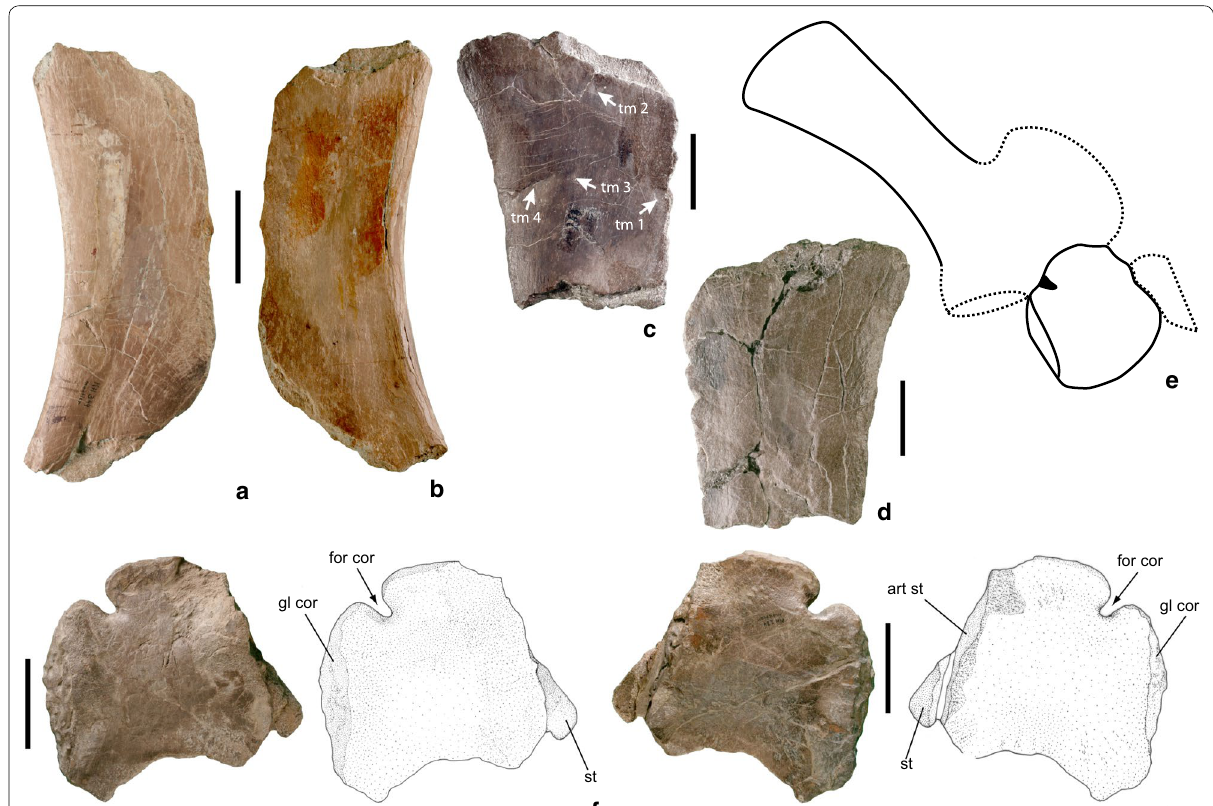
Fig. 9 Scapula and coracoid of A. greppini . NMB M.H. 344, right scapular shaft a in lateral and b in medial aspect. NMB M.H. 368, distal extremity of left scapula c in lateral aspect, arrows indicate at least four different tooth marks and d in medial aspect. e Reconstructed outline of scapulocoracoid of A. greppini , based on the scapular remains and the coracoid, hatched outline indicates regions that are not preserved. NMB M.H. 284, right coracoid, photograph (left) and drawing (right), f in lateral and g in medial aspect. Scale bar is 50 mm. Drawings by Serafin Padzera. art st articular surface of sternal bone, for cor coracoid foramen, gl cor glenoid surface of coracoid, st sternum fragment, tm tooth